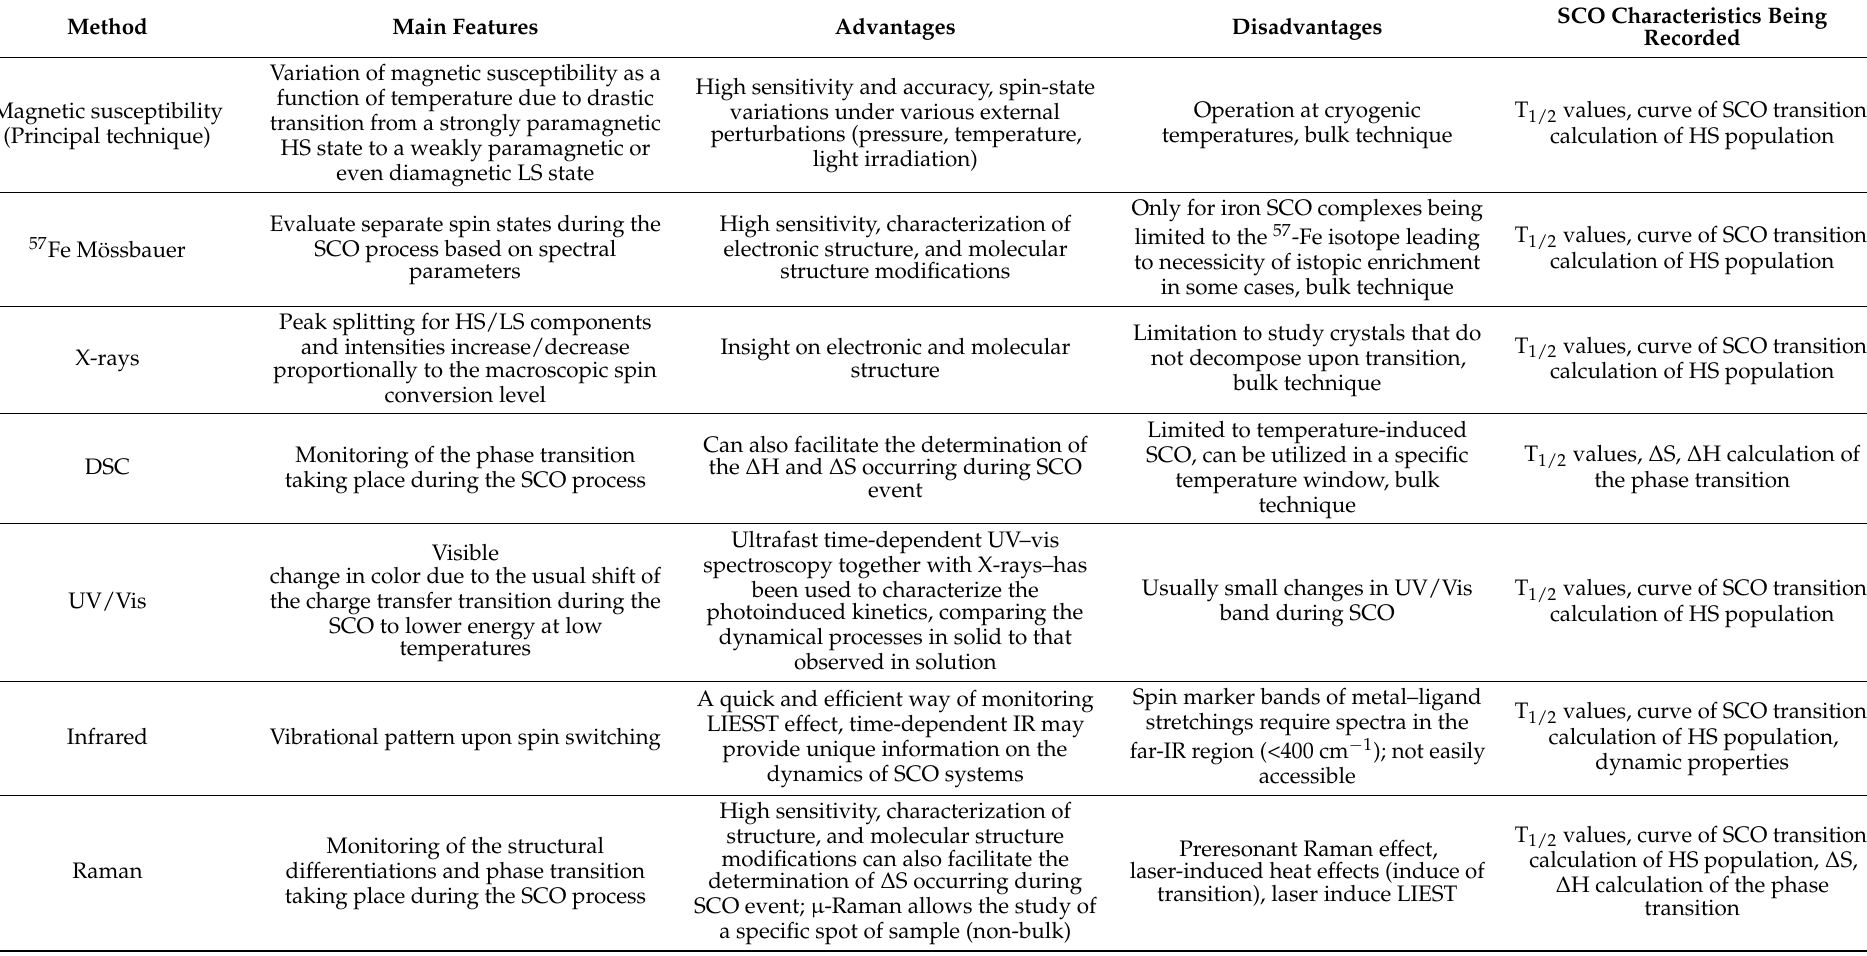
Table 1. Main features, advantages and disadvantages of selected methods for the monitoring of the spin-crossover